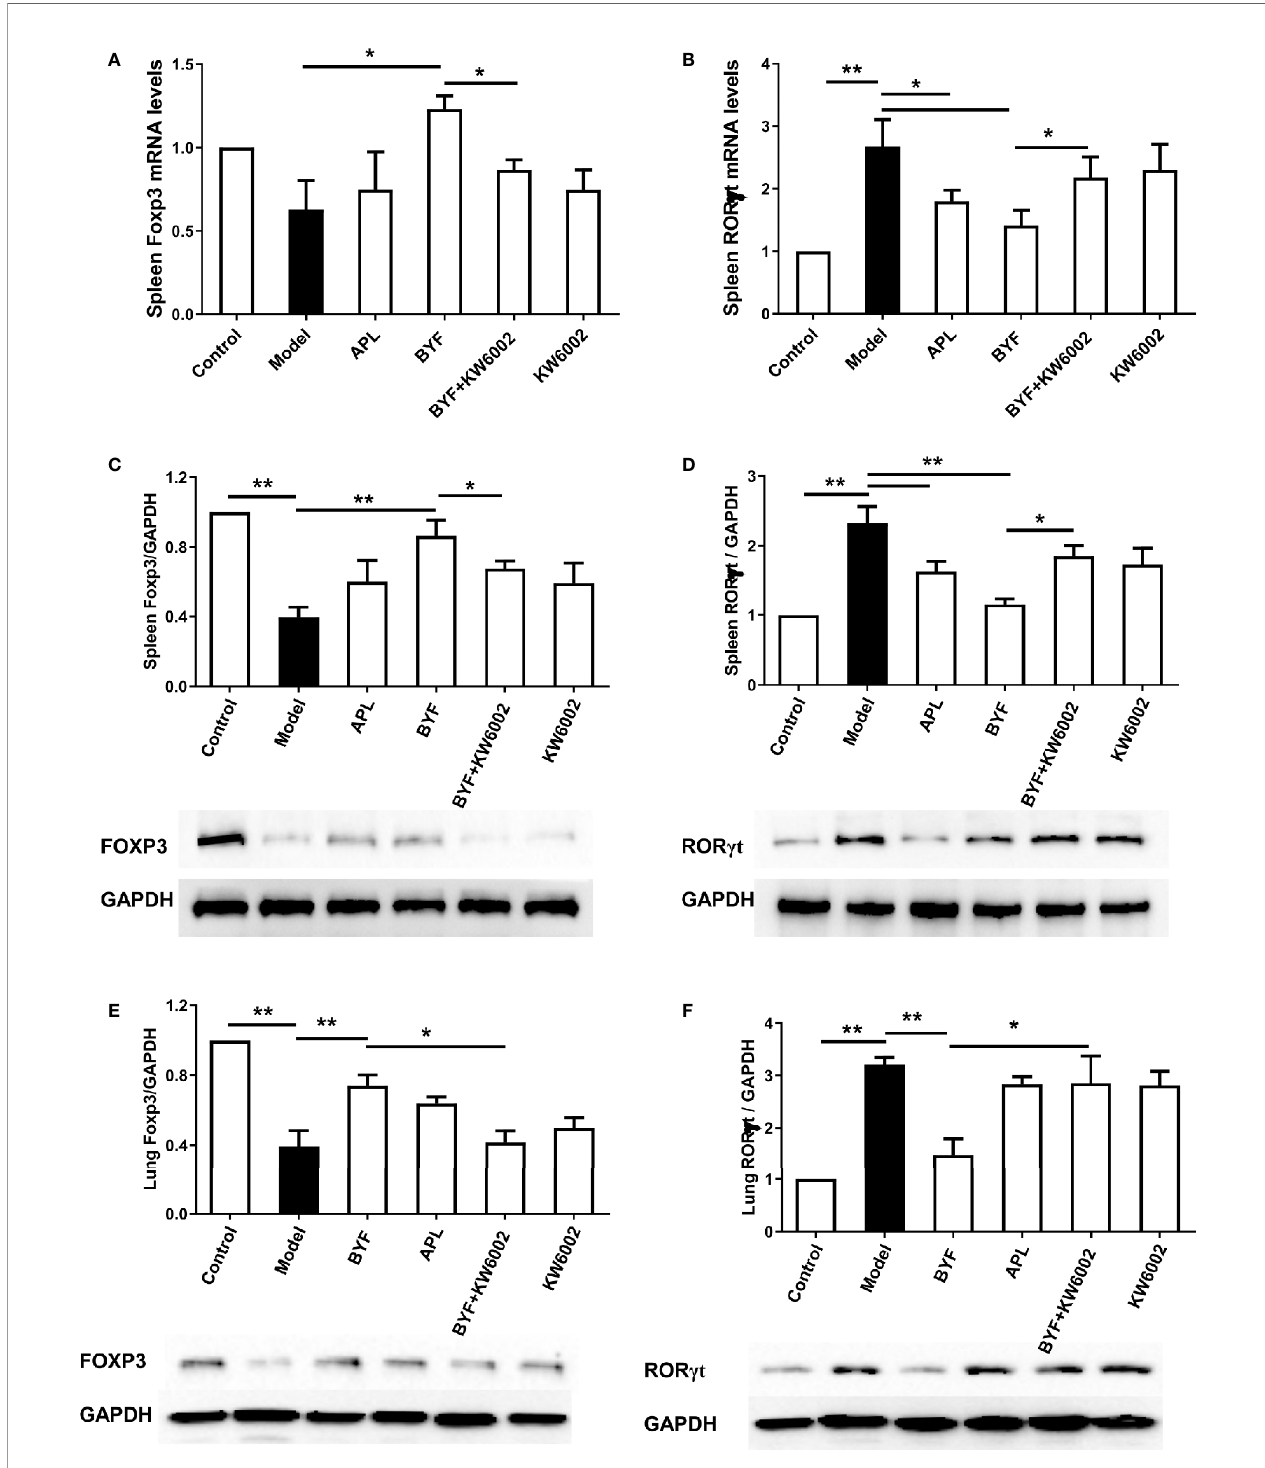
FIGURE 7 | Effect of cotreatment of Bufei Yishen formula (BYF) and A2aR antagonist on the mRNA levels of ROR g t and Foxp3 in the spleens of chronic obstructive pulmonary disease (COPD) rats. The mRNA levels for Foxp3 (A) and ROR g t (B) in the spleens were analyzed by a quantitative polymerase chain reaction (PCR) assay. The protein levels for Foxp3 (C) and ROR g t (D) in the spleens, and Foxp3 (E) and ROR g t (F) in the lung were detected by Western blotting. The values are presented as the means ± SEM (n=6 mice per group). *P < 0.05, **P <